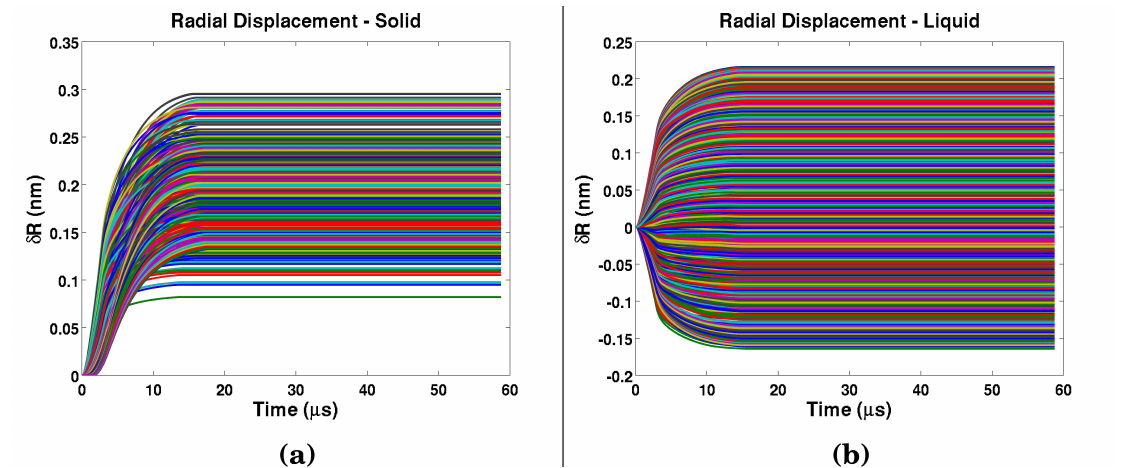
Figure 7. The pressure vessel steel particle radial movement as a function of time, both for the ( a ) solid particles and the ( b ) liquid water